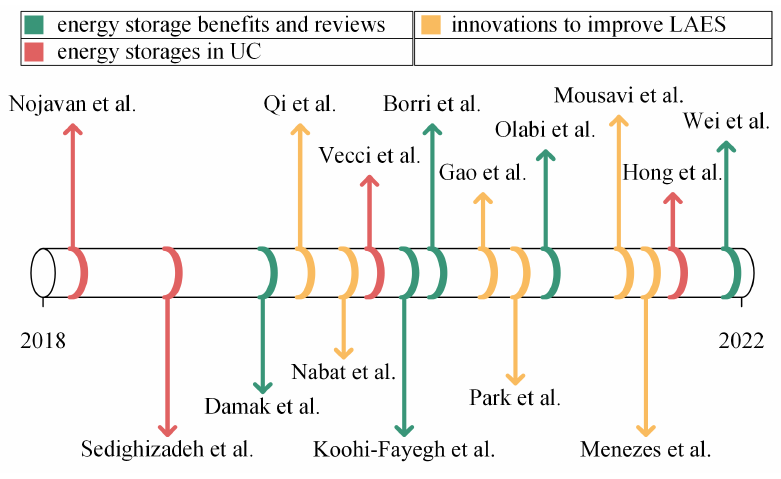
Figure 1. Summary of references